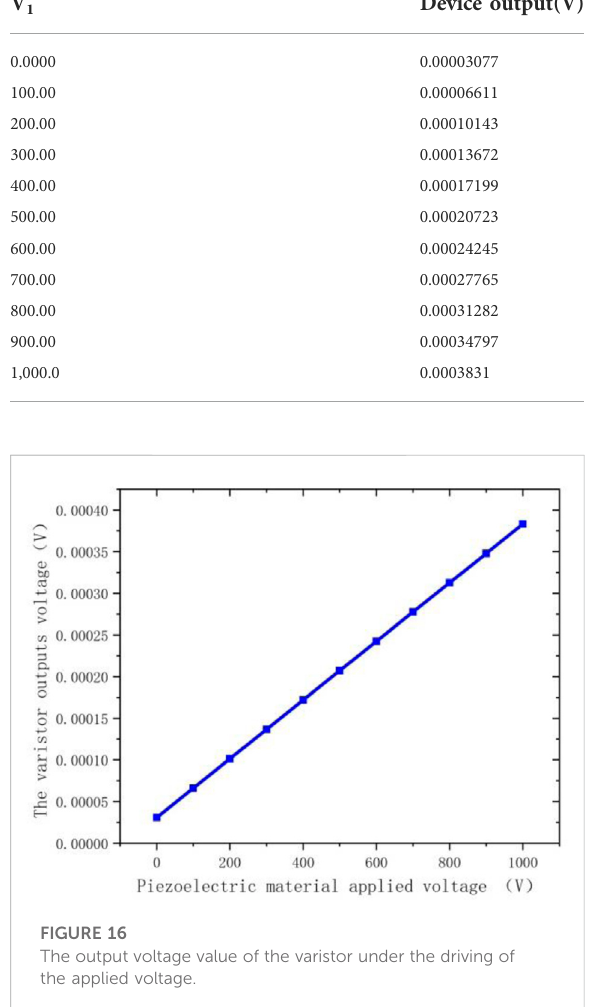
FIGURE 16 The output voltage value of the varistor under the driving of the applied voltage.